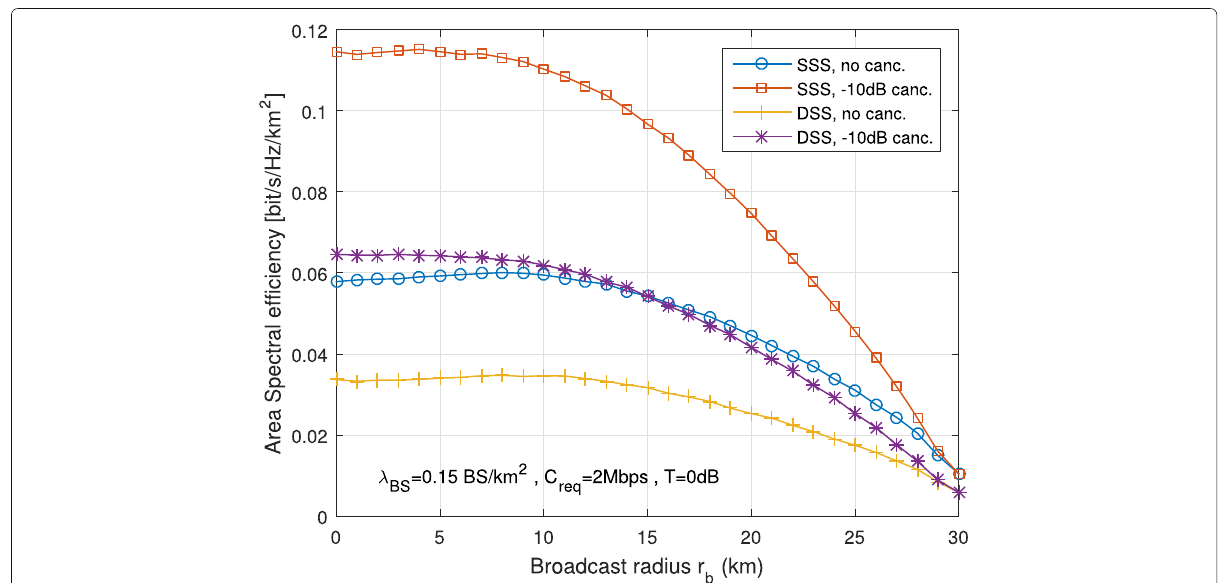
Fig. 16 Global area spectral efficiency comparison between the two proposed scenarios with and without interference cancellation (SSS = shared spectrum scenario, DSS = dedicated spectra scenario)